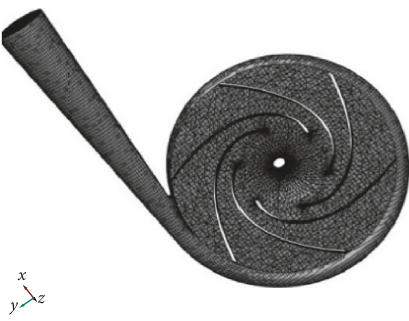
Figure 2: Mesh generation. Table 1: Boundary condition